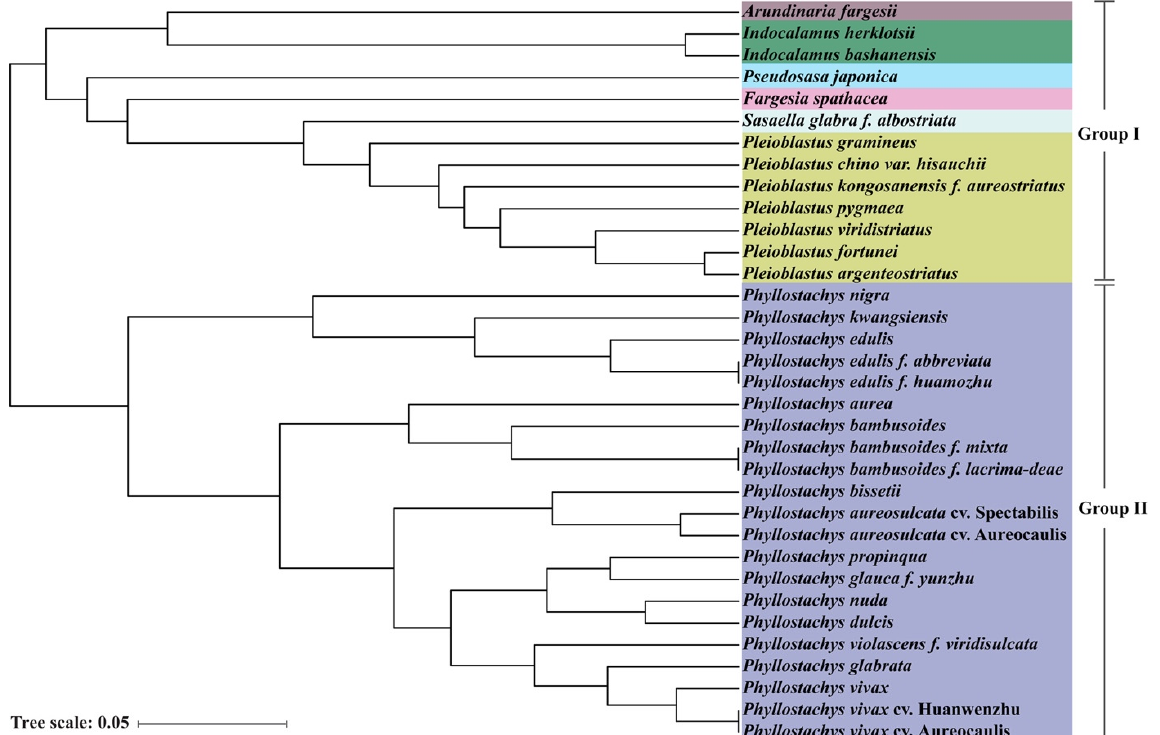
Figure 7. Cluster analysis of 34 bamboo accessions in seven genera based on SSR data. Different colors represent different genera.